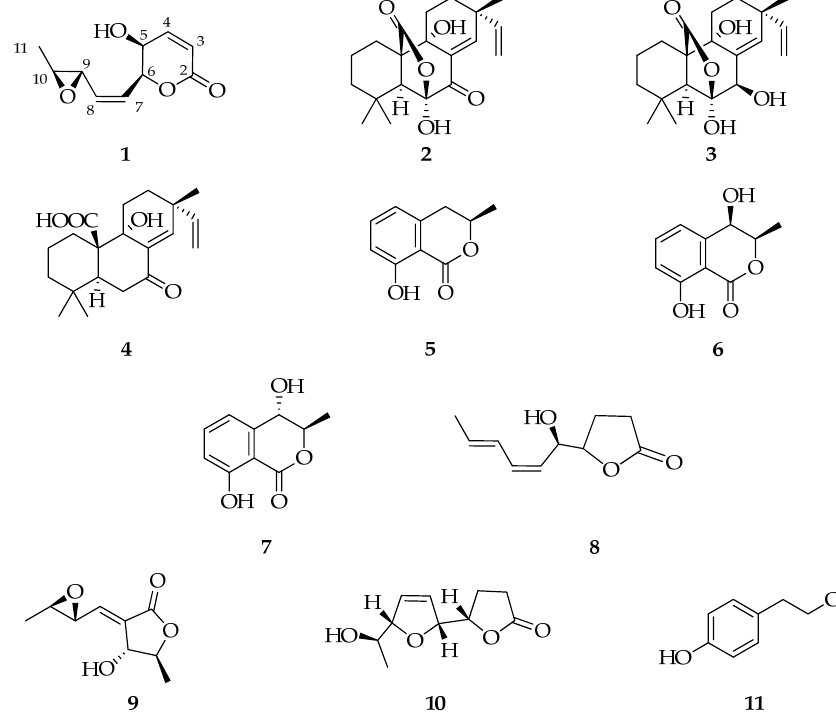
Figure 1. Structures of diplopyrone C ( 1 ), sphaeropsidins A ( 2 ), B ( 3 ), and C ( 4 ), (3 R ) ‐ mellein ( 5 ), (3 R ,4 R ) ‐ ( 6 ), and, (3 R ,4 S ) ‐ 4 ‐ hydroxymelleins ( 7 ), sapinofuranone B ( 8 ), pinofuranoxin A ( 9 ), diplobifuranylone B ( 10 ), and tyrosol ( 11 ).